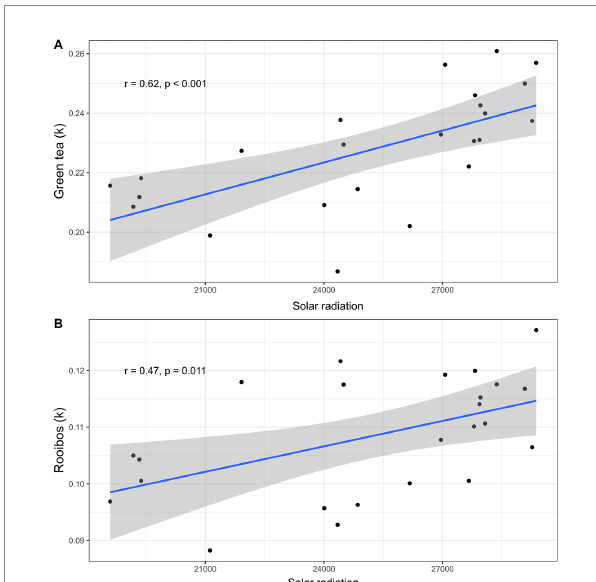
FIGURE 6 Effect of solar radiation on teabags decomposition. Scatterplots displaying liner regressions (blue lines with confidence intervals in grey) between solar radiation and k values for (A) green tea (linear regression; n = 24, r = 0.62, p < 0.001), and (B) rooibos tea (linear regression; n = 24, r = 0.47, p =